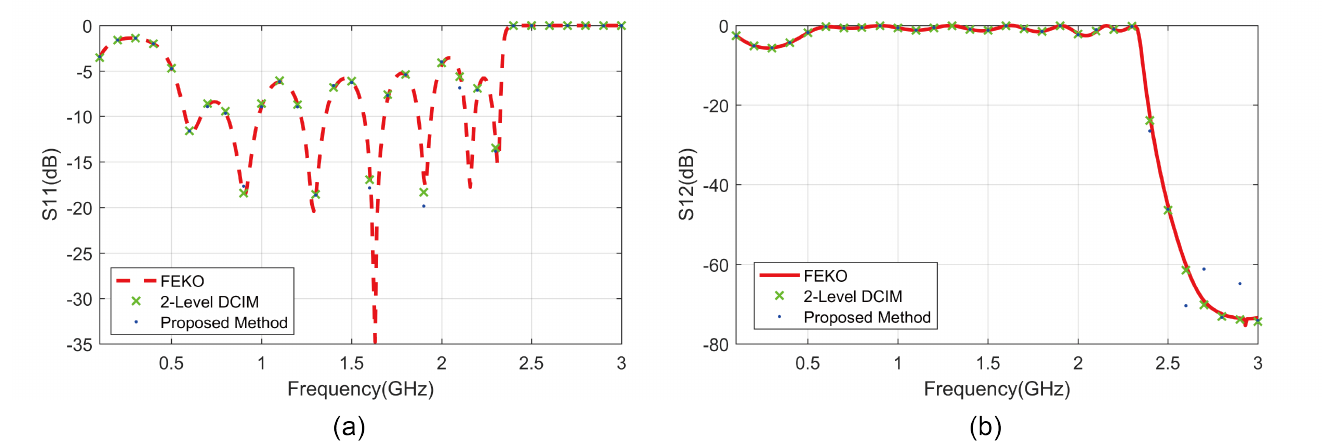
Figure 7. S − parameter of the two-port low-pass filter evaluated by different methods, ( a ) S11, and ( b )